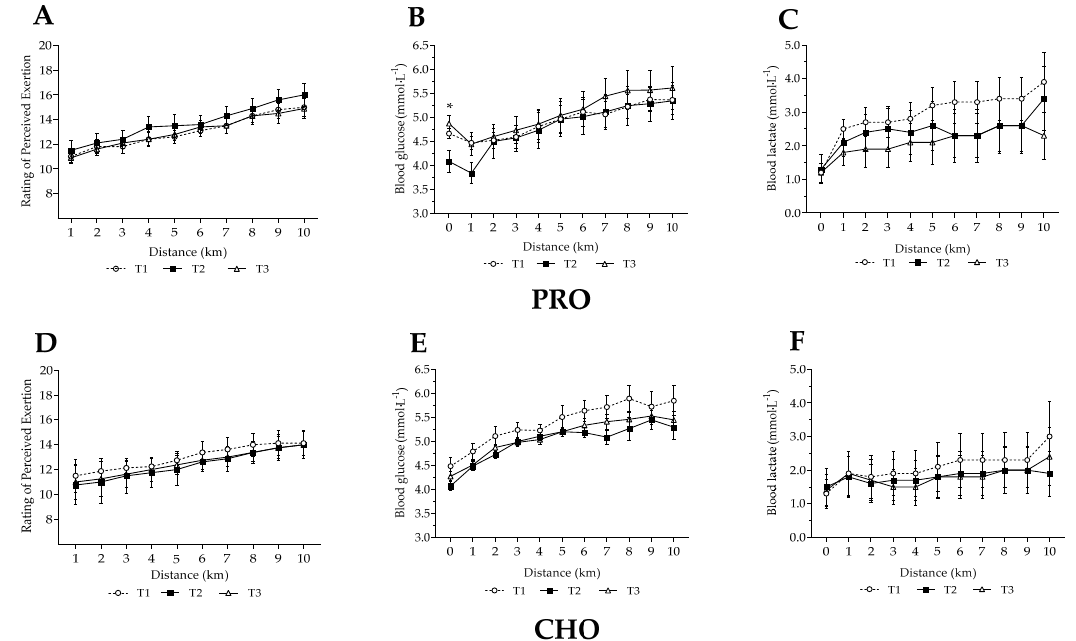
. VO 2max following